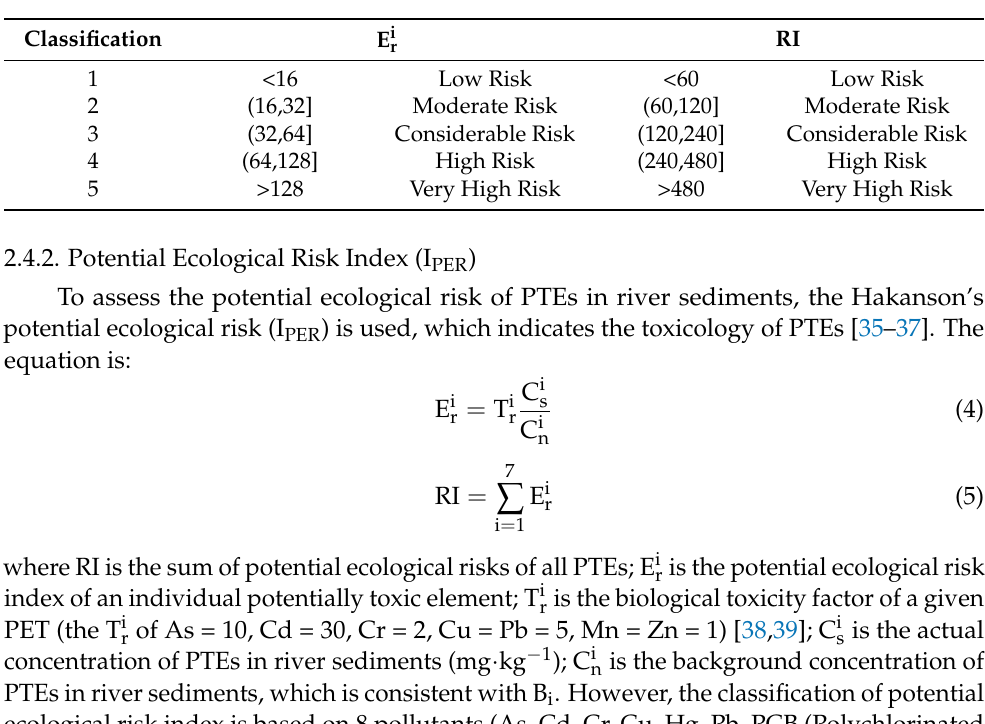
Table 1. The classification criteria for potential ecological risk